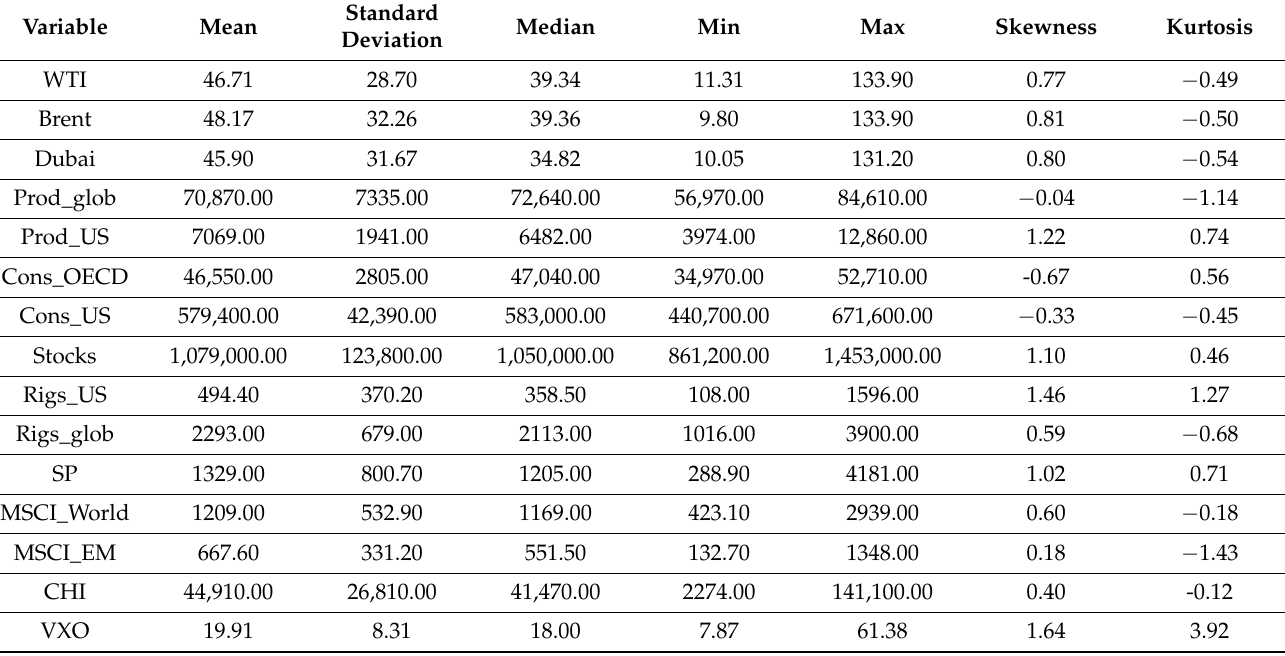
Table 2. Descriptive